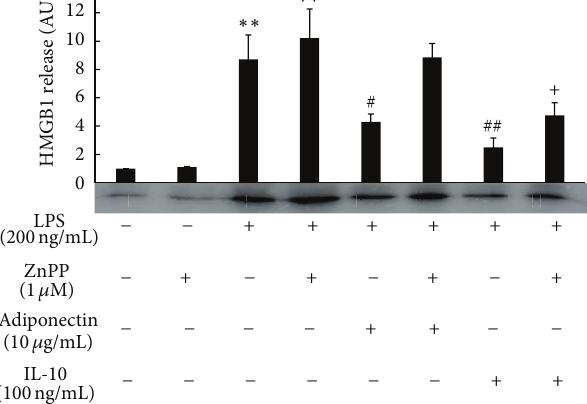
Figure 4: Effect of an HO-1 inhibitor on the anti-inflammatory action of adiponectin or IL-10 on LPS-induced HMGB1 release. Raw 264 cells were cultured as described in Figure 1 legend and were treated with dimethyl sulfoxide (DMSO, control) or ZnPP (1 𝜇 M) for 1h before treatment with adiponectin (10 𝜇 g/mL) or IL-10 (100ng/mL) for 18 h. Cells were then stimulated with LPS (200 ng/mL) for another 24 h. Culture medium was collected and analyzed by HMGB1 western blotting followed by quantification of the intensity of the chemiluminescent HMGB1 band. The results are expressed as means ± SE of three independent experiments ( ∗∗ 𝑝 < 0.01 significance compared with control; ## 𝑝 < 0.01 and # 𝑝 < 0.05 significance compared with LPS treated cells; + 𝑝 < 0.05 significance compared with LPS plus ZnPP treated cells).